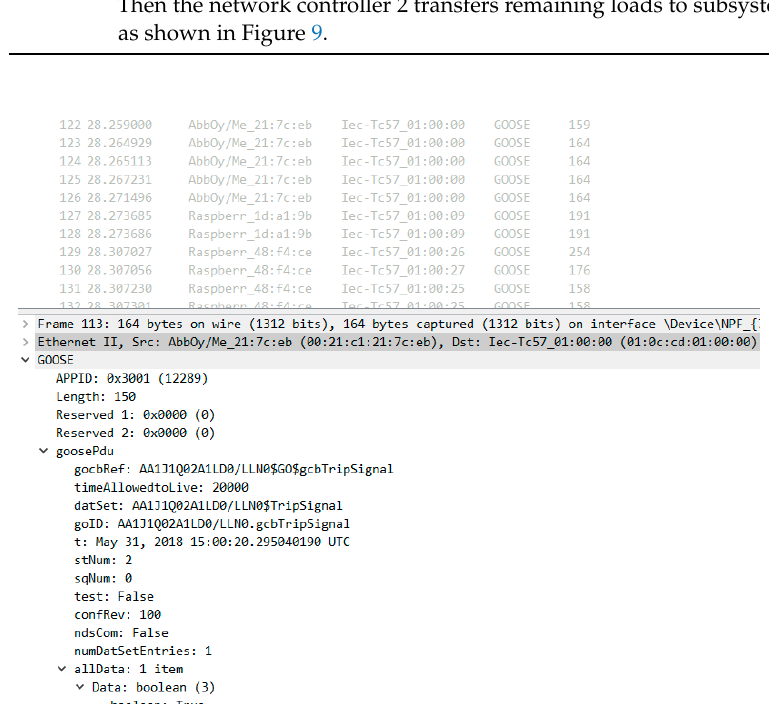
Figure 10. Snapshot of generated IEC 61850 messages during F-FDIR process. Figure 8. Snapshot of generated IEC 61850 messages during F-FDIR